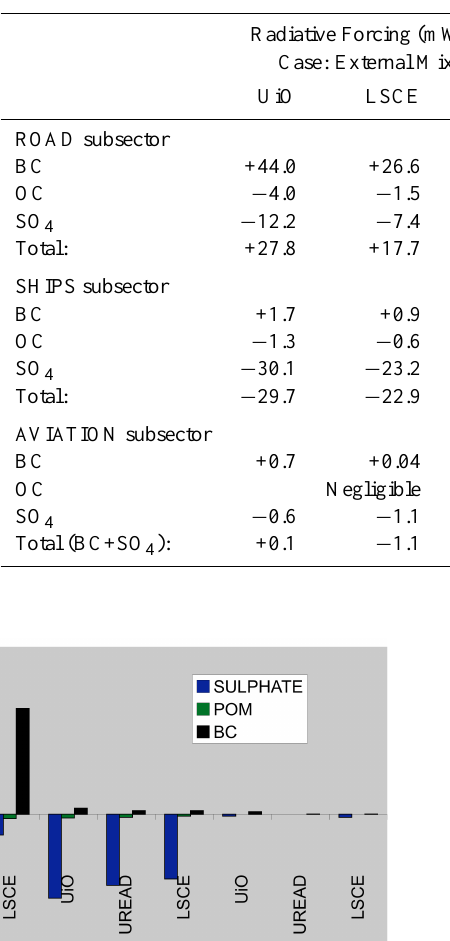
Table 2. Global-mean all-sky radiative forcing of the three aerosol components emitted from the road, ship and aviation sub-sectors. Radiative forcings are given for both an external and an internal mixture case.